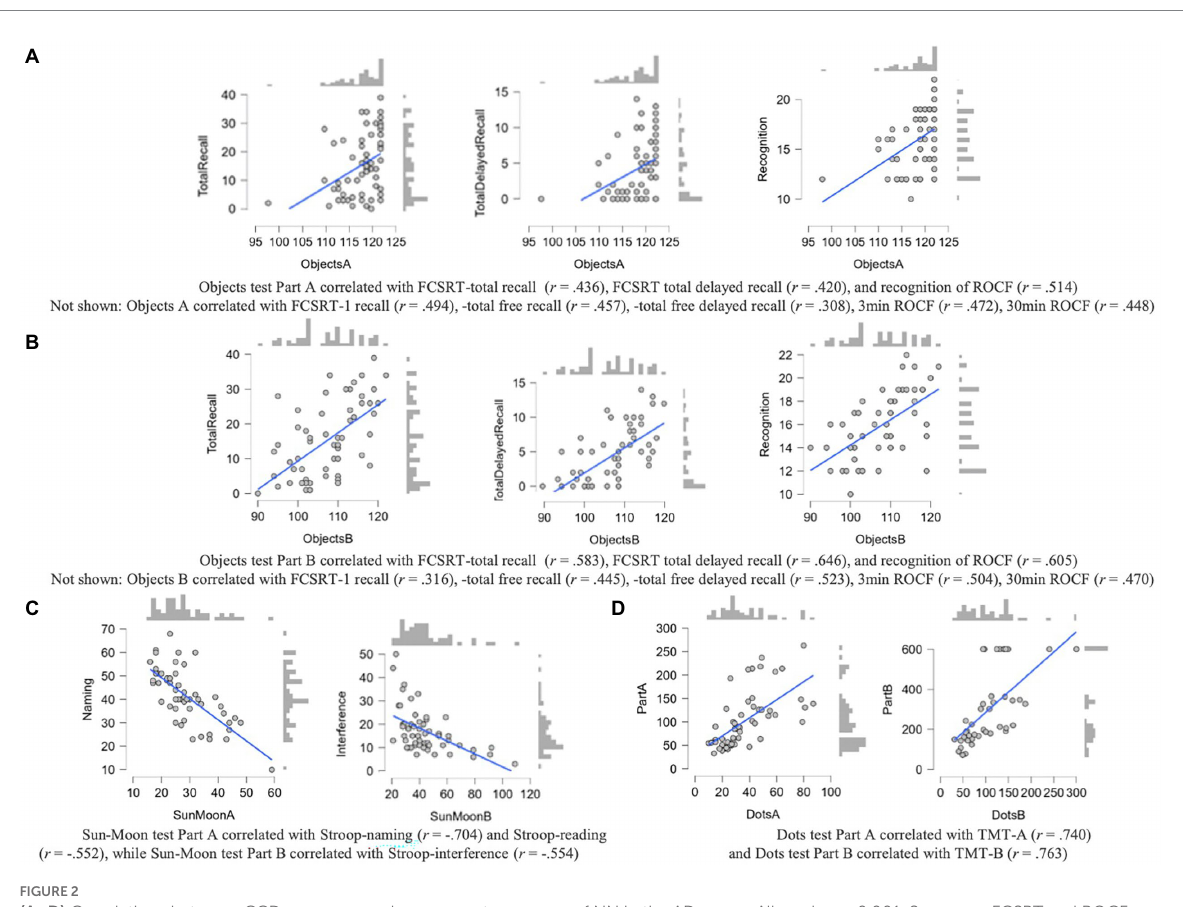
FIGURE 2 (A–D) Correlations between CCD measures and convergent measures of NN in the AD group. All p values <0.001. Scores on FCSRT and ROCF were correlated with Objects test Part A scores (A) and Objects test Part B scores (B) . Scores on Sun-Moon test Part A were correlated with Stroop – word reading scores, while Part B was associated with Stroop – interference (C) . Dots test Part A was correlated with TMT-A and Part B with TMT-B (D)